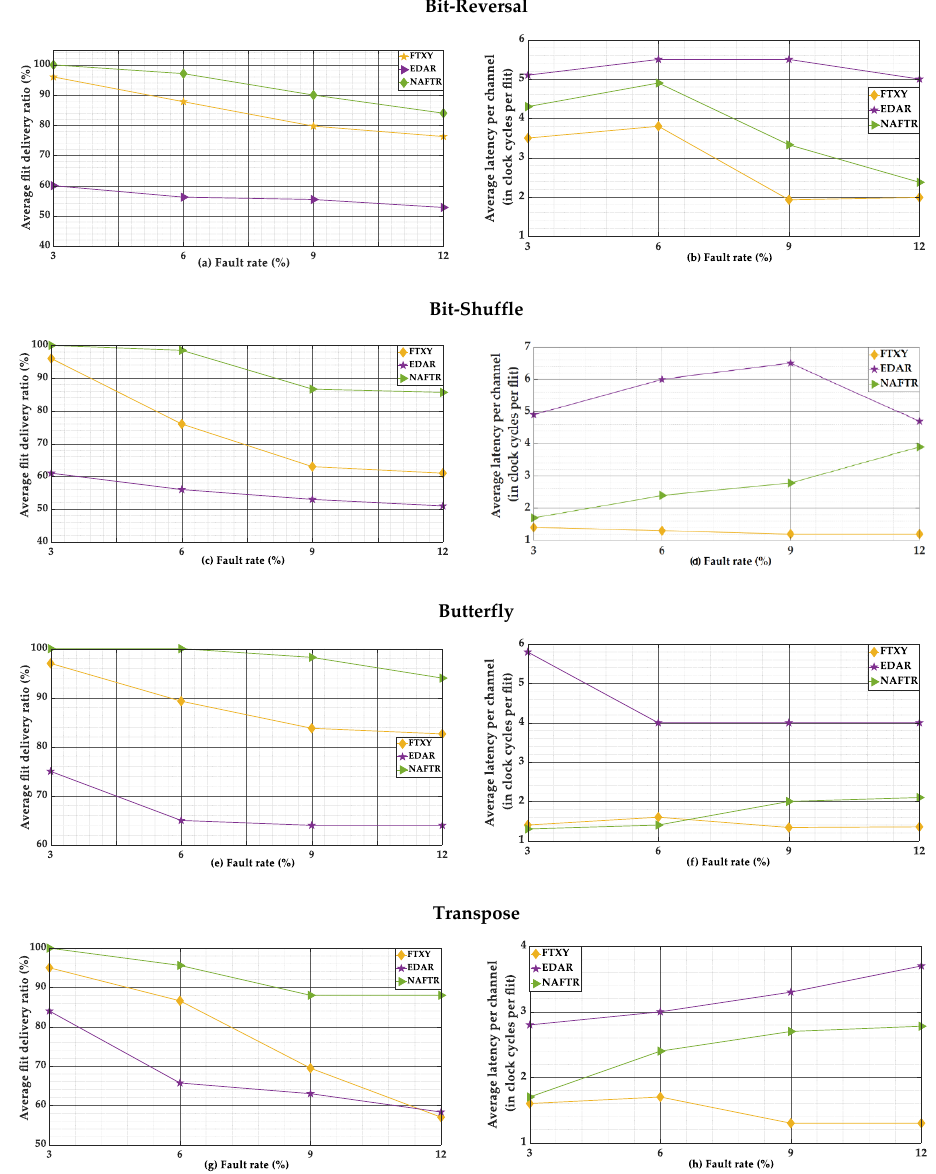
Figure 8. Overall average latency vs. flit delivery ratio comparison at different fault induction rates under synthetic traffic patterns.